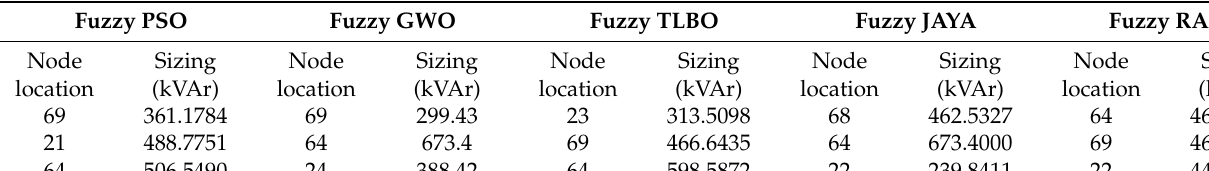
Table 8. DSTATCOM optimum location and sizing.